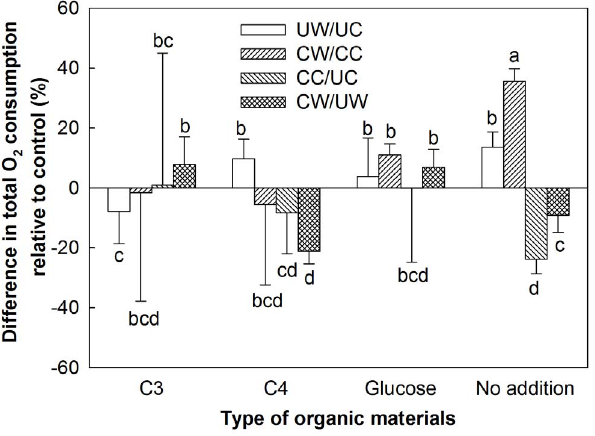
Figure 3. Warming- and clipping-induced changes in soil respiratory C release (%) with the addition of C 3 plant material, C 4 plant material, or glucose or without substrate addition during the incubation period under four treatments: UC: unclipped control; UW: unclipped and warmed; CC: clipped and control; CW: clipped and warmed. The comparisons included the effects of warming on soil respiratory C release with (CW/CC) and without (UW/UC) clipping, and the effects of clipping under control (CC/UC) and warming (CW/UW) treatments. Vertical bars and their error bars represent means and standard errors ( n 5 4). The different letters indicate statistical